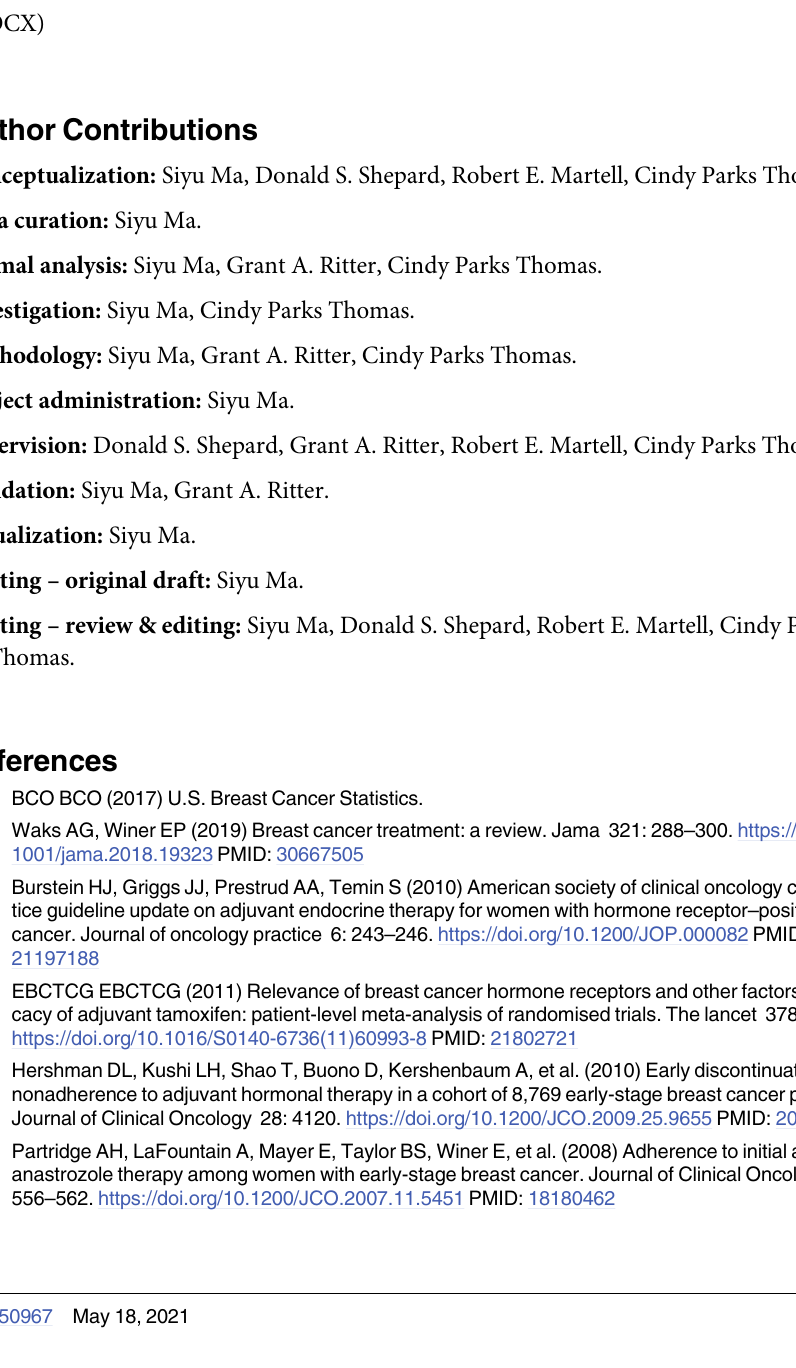
S4 Table. Model-based adjusted AI adherence measured by medication possession ratio (%) among Medicare and Medicaid dual eligible beneficiaries diagnosed with hormone receptor-positive early stage breast cancer from 2007 to mid-2009. S5 Table. Unadjusted percentage of dual eligible beneficiaries were persistent (no more than 90-, and 180-day gaps between two filled prescriptions) to hormone therapy from year 1 to year 5, by treatment and control groups. S6 Table. Model-based adjusted odds ratio of predictors for AI non-persistence (at least one 90-, and 180-day gaps) among women diagnosed with hormone receptor-positive early stage breast cancer from 2007 to